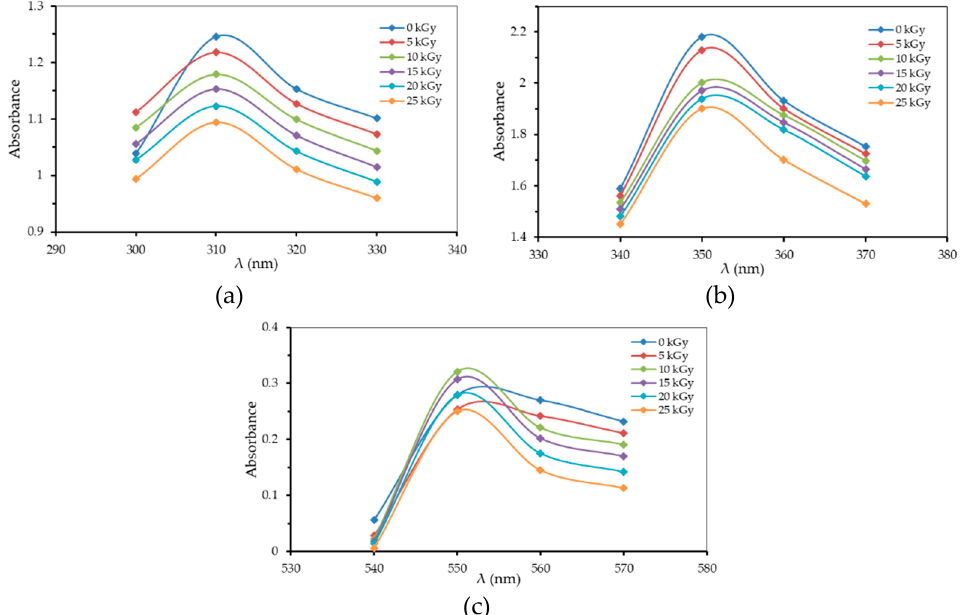
Figure 1. The relationship between absorbance (A) and wavelength ( λ ) for phosphoric acid (H3PO4) 75 v% concentration for each radiation dose: ( a ) λ = 310 nm (peak I); ( b ) λ = 350 nm (peak II); ( c ) λ = 550 nm (peak III).